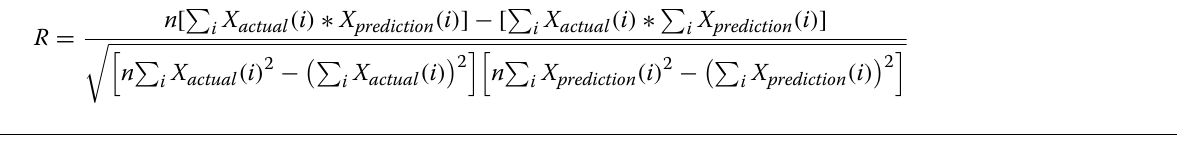
Table 3 Coefficient of correlation for different ANN architectures in the prediction of the OAC testing set OAC